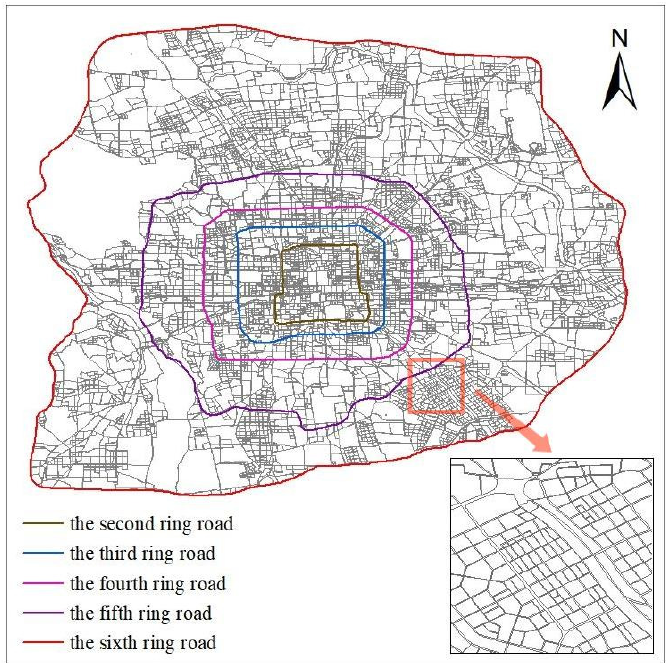
Figure 2. Blocks in the study area.